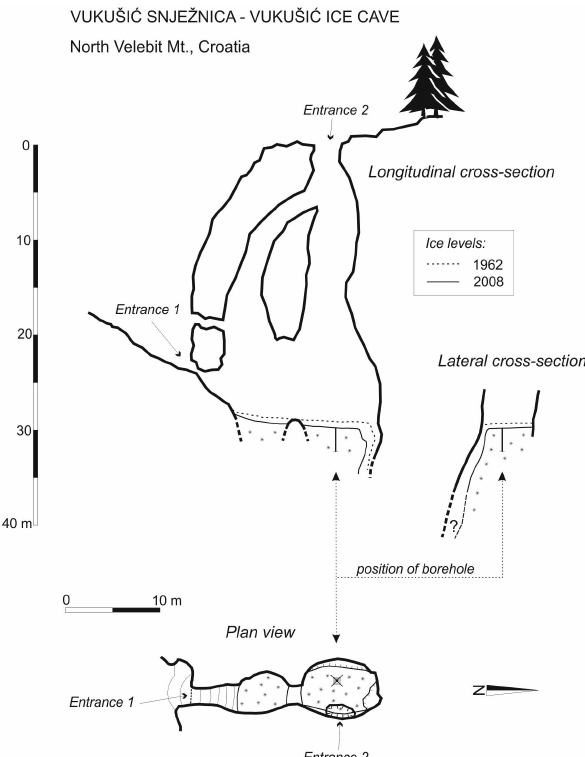
Fig. 2. Sketch of Vukuši´c Ice Cave (redrawn after Kuhta, 2002) with lines marking the ice level at the given date (according to SDH 1962 and recent observations). The ice core locations are